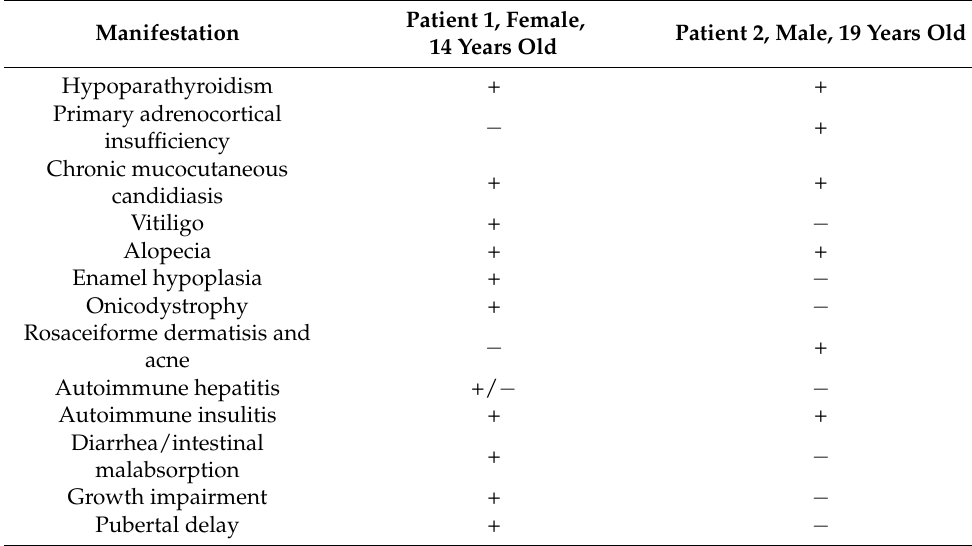
Table 1. Manifestations of two siblings affected by autoimmune polyendocrinopathy–candidiasis– ectodermal dystrophy (APECED) disease: variability and